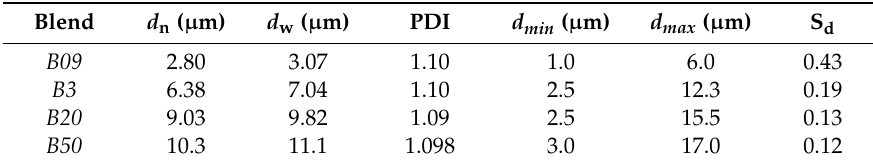
Table 3. Statistical analysis of particle size distribution of dispersed PP phase in PS80 / PP20 blends with di ff erent viscosity ratios ( K